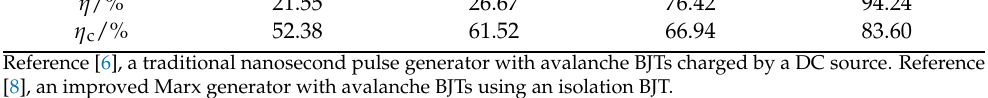
Figure 11. The waveform of the energy-storage capacitors U c and the resonant current i r (circuit II).